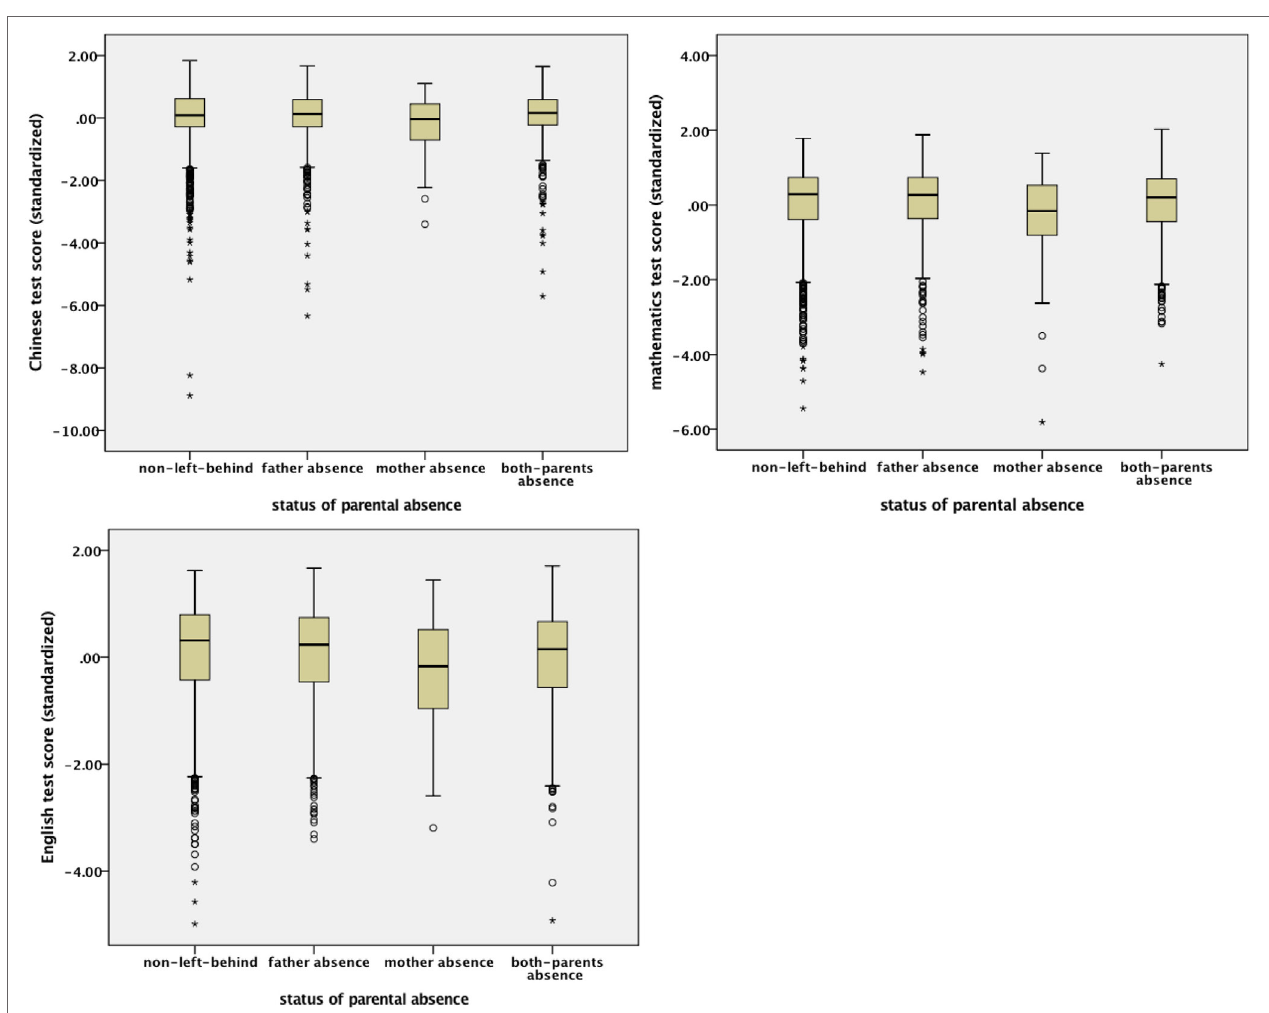
Figure 1 | Statistical distribution of test scores (standardized) of children with different status of parental absence.